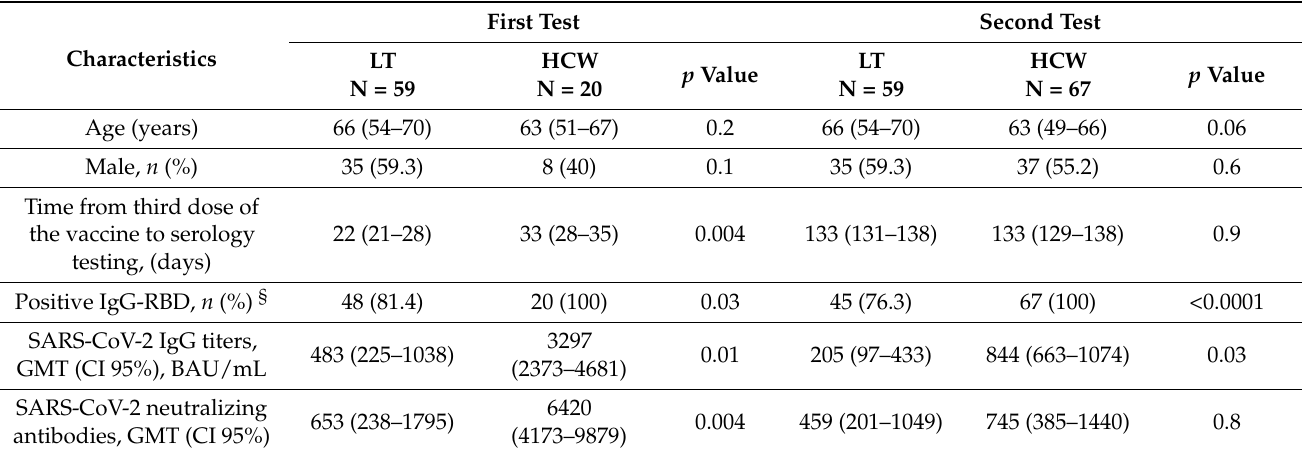
Table 1. Demographic characteristics and immunologic responses of liver transplant (LT) patients and healthy healthcare workers (HCW) to a third BNT162b2 mRNA vaccine